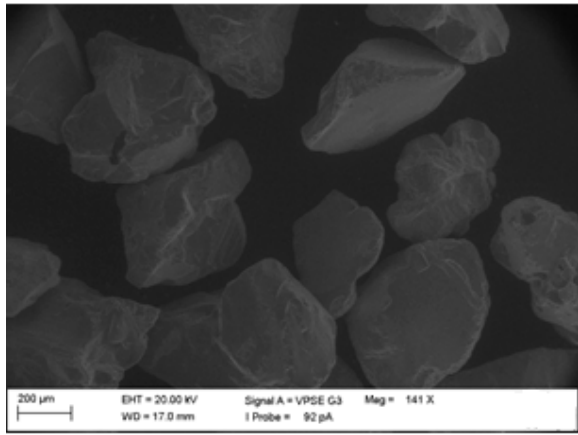
Figure 6. SEM image of Al 2 O 3 abrasive particles with angular geometry.